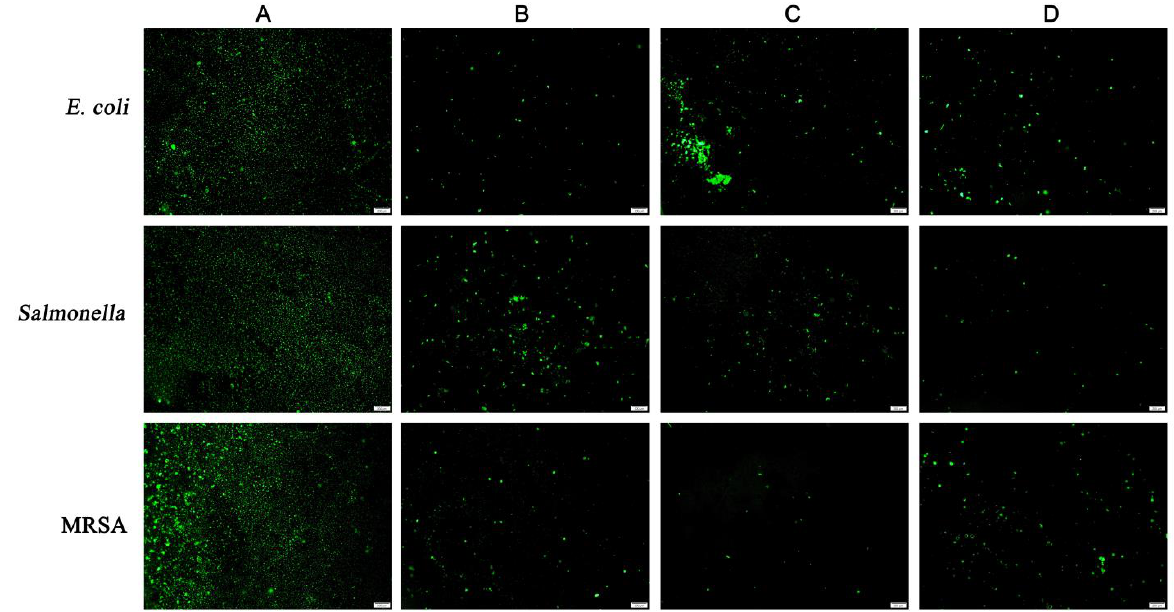
Figure 2. Effects of ethyl acetate extracts from the endophytic fungi on the cell membrane integrity of E. coli, Salmonella, and MRSA by fluorescence microscope. ( A ) Untreated bacterial cells; ( B ) bacterial cells treated with P. sclerotigenum extracts at 2MIC; ( C ) bacterial cells treated with D. kochmanii extracts at 2MIC; ( D ) bacterial cells treated with P. trachycarpicola extracts at 2MIC. The scale bar was 200 µm.